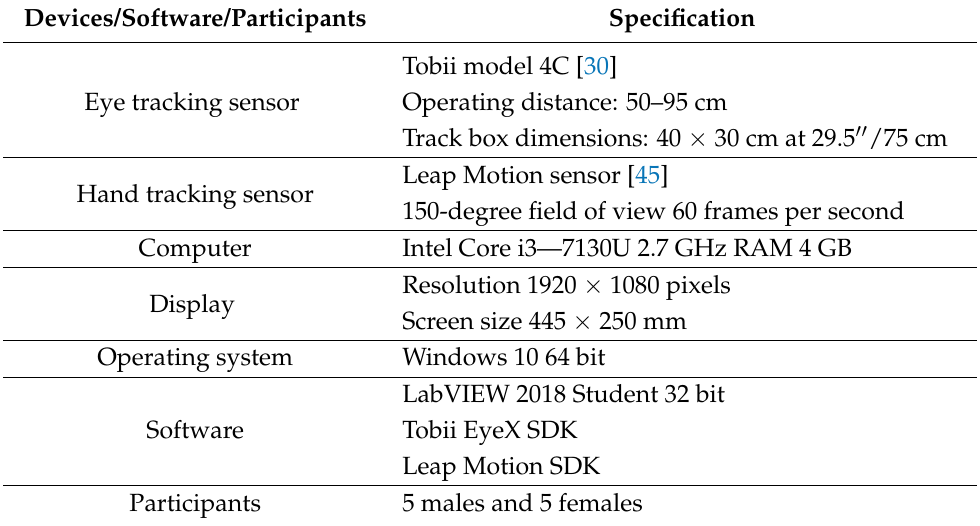
Table 1. System configuration and experimental setup.